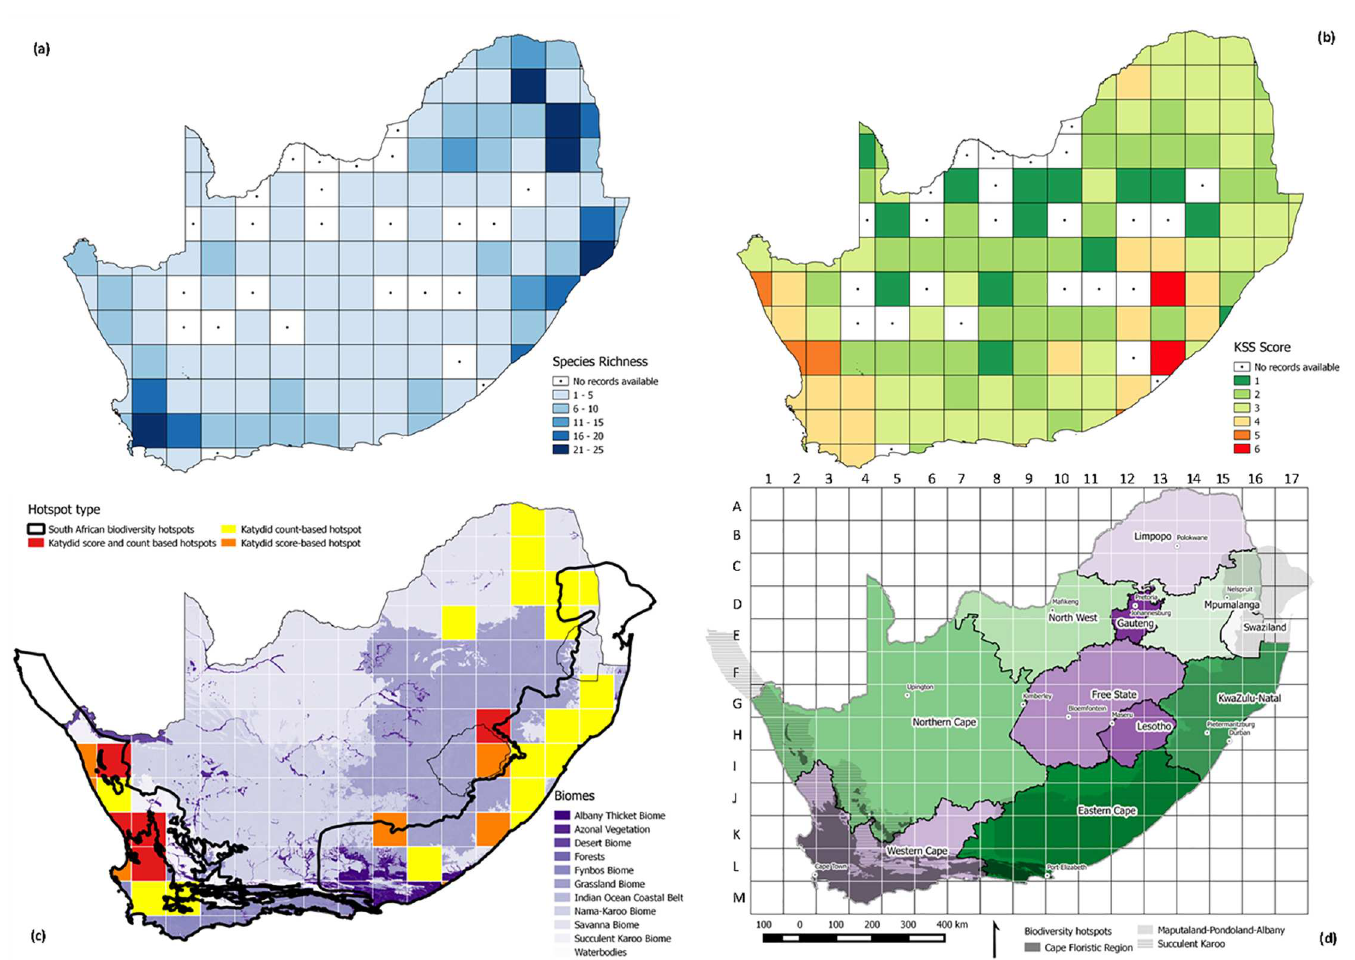
Fig 5. Katydidhotspotmaps. Maps of katydid totalspecies richness(a),mean T+D+LH scores (b),katydid and biodiversity hotspotlocations(c), and a reference map illustratinggeographic regions in South Africa,Lesothoand Swaziland (d).